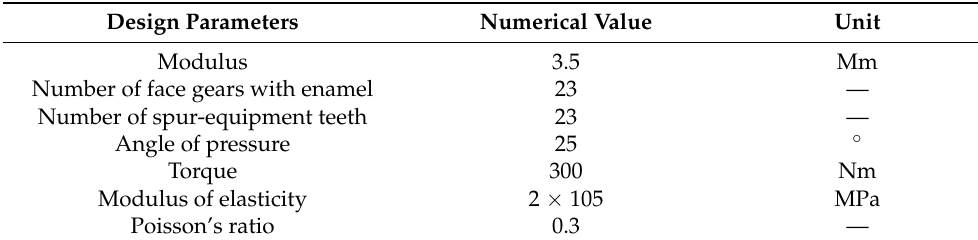
Figure 10. Impact of roughness on the face-gear maximum contact stress.